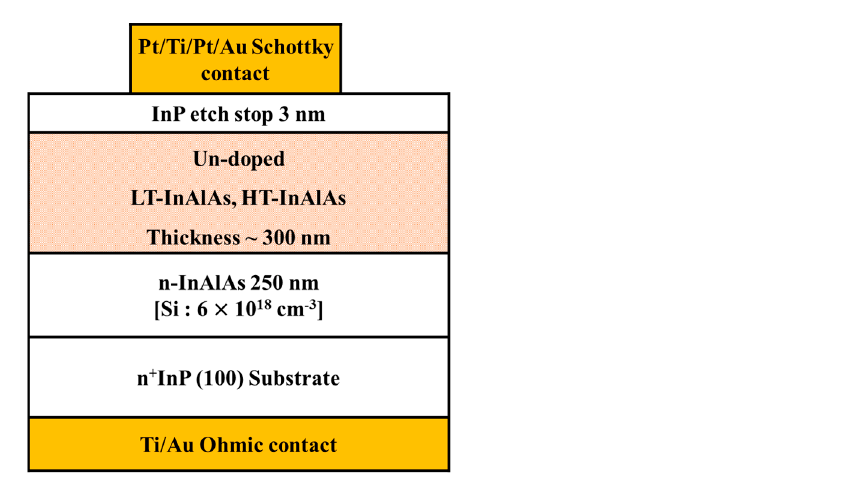
Figure 1. A schematic diagram of a Schottky diode with LT- and HT-InAlAs barriers.